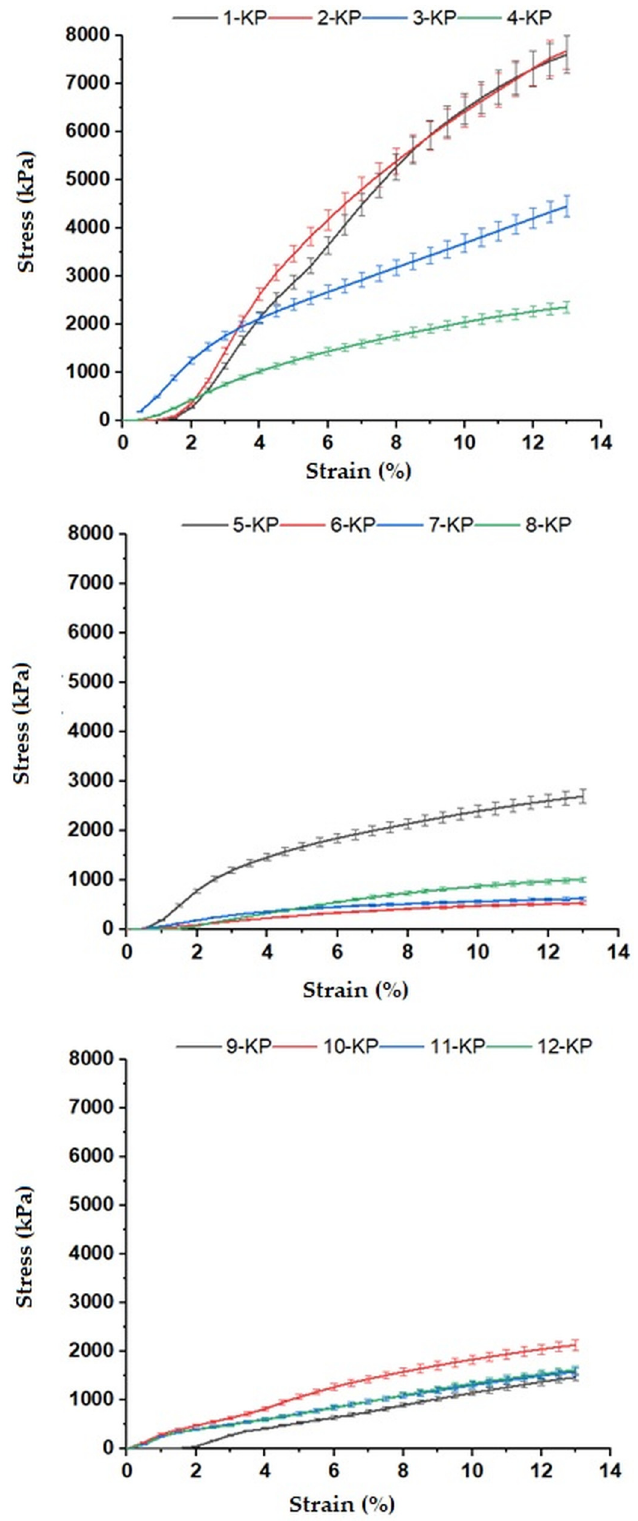
Figure 5. Stress–strain curves of polyDCPD composites.